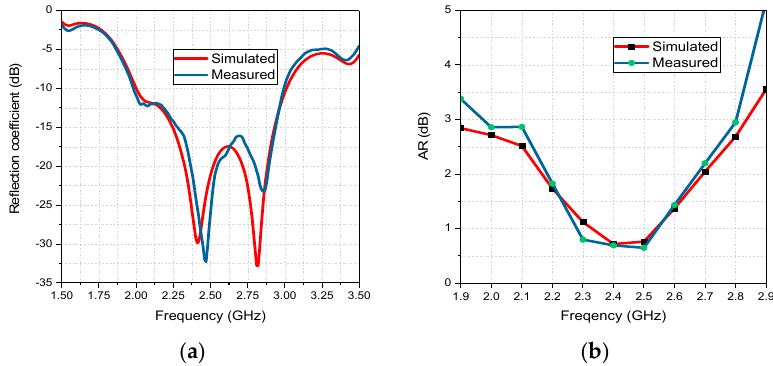
Figure 4. ( a ) Simulated and measured reflection coefficients. ( b ) Simulated and measured ARs.